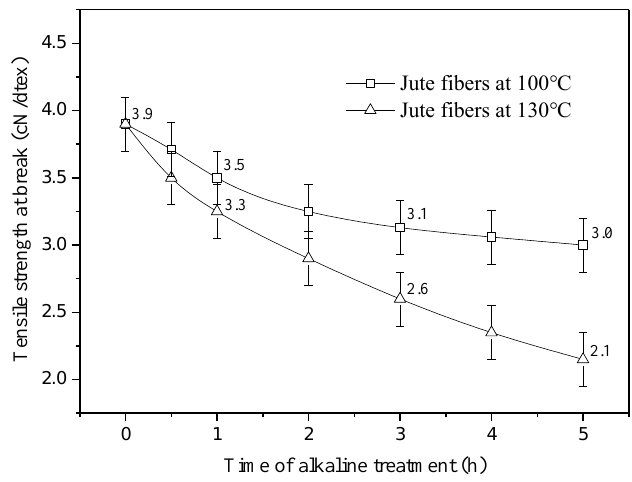
Figure 7. Tensile strength at break of jute fibers pretreated at 100 and 130 °C.